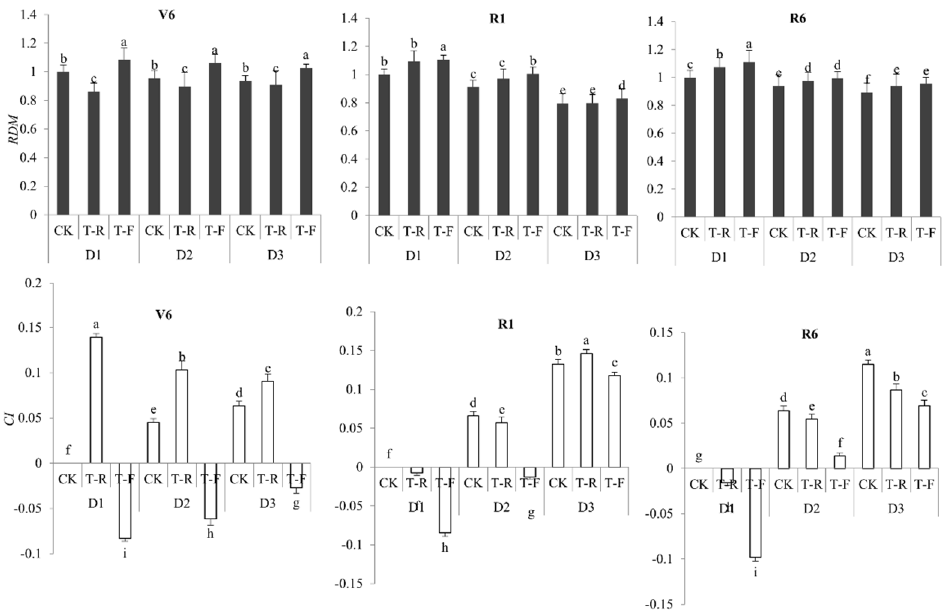
Figure 8. Relative dry matter weight ( RDM ) and competitive intensity ( CI ) of maize under different planting patterns (2018a). At the same testing time different letters above the bars indicate that there is a significant difference between treatments at p < 0.05. D1, D2 and D3 represent maize were planted at 60,000, 75,000, and 90,000 plants ha − 1 , respectively. CK and T represent maize were planted in the conventional flat planting pattern and in the stereo-planting pattern, respectively. T-R and T-F represent maize were planted on the ridge and in the furrow, respectively. V6, R1 and R6 represent 6-leaf stage, 12-leaf stage and physiological maturity, respectively. The vertical bar means the standard errors ( n = 3).